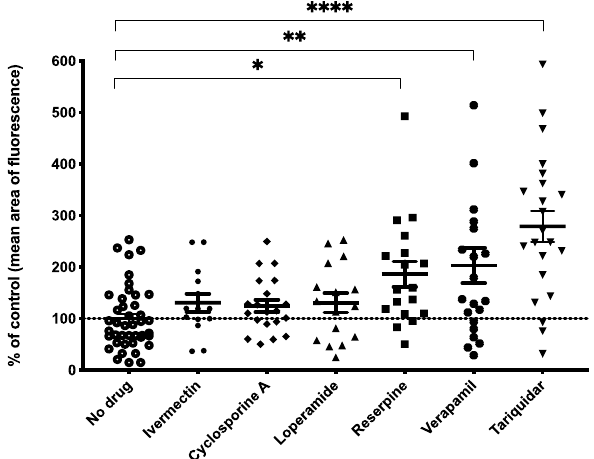
Figure 3. Increased H33342 staining of T. canis larvae exposed to P-gp inhibitors. Mean ± SE are shown, asterisks indicate P-gp inhibition relative to no drug control. (Asterisks indicate groups that are significantly different, **** p < 0.0001, ** p < 0.01, * p <